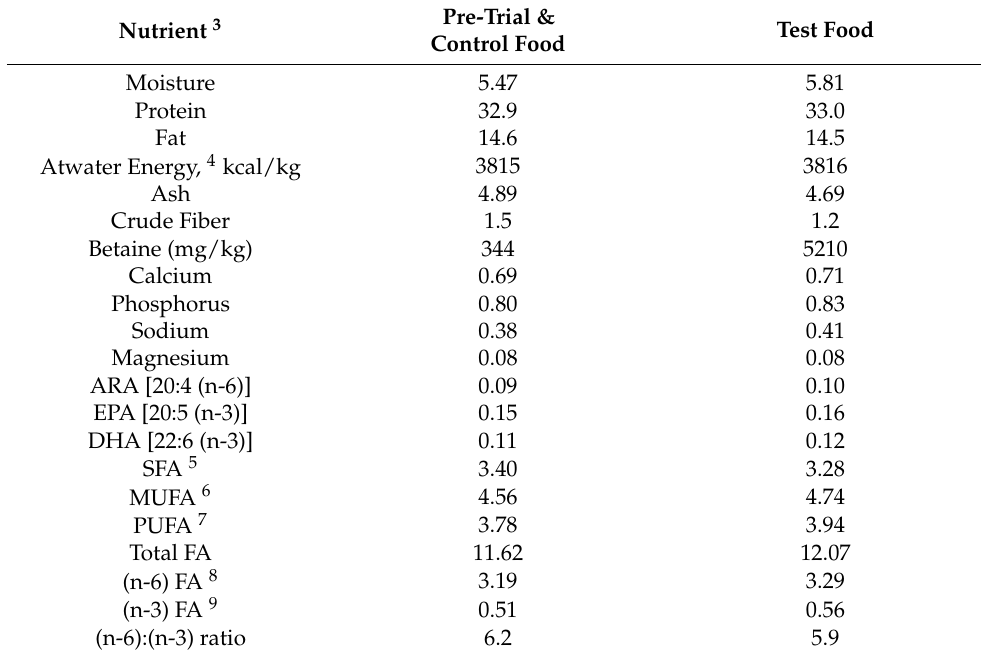
Table 1. Composition of pre-trial (control food) 1 and test food 2 . Nutrient 3 Test